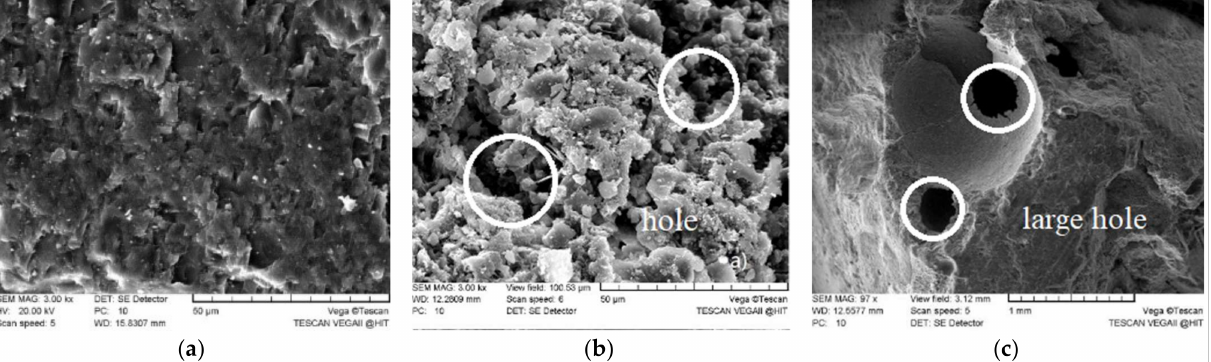
Figure 2. SEM images of the plain concrete in different CO 2 concentrations. ( a ) No corrosion, ( b ) 8% CO 2 concentration, and ( c ) 10% CO 2